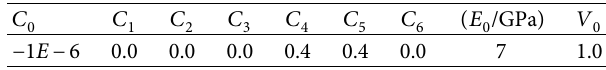
Table 2: Material parameters of air. Table 3: Material parameters of